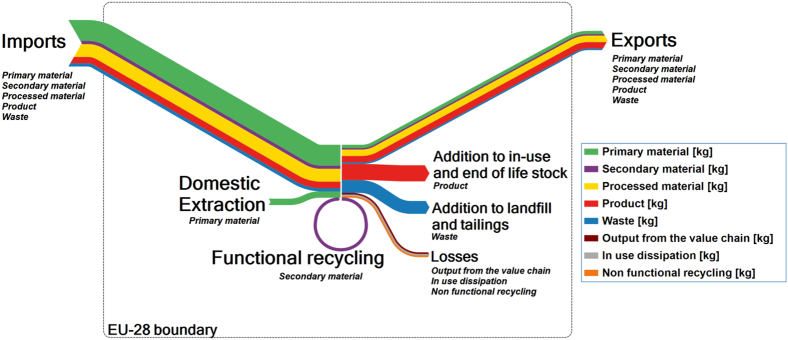
Simplified Sankey diagrams from the MSA study (BIO by Deloitte, 2015) showing the flows (in kg/year, usually in metal content) used in the calculation of anthropogenic mobilization of TCEs by the EU-28.